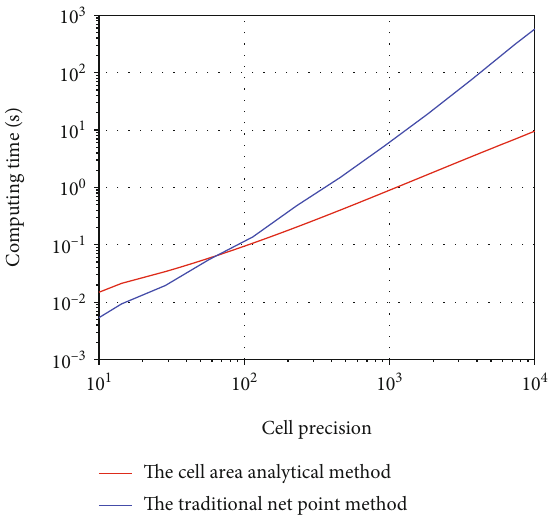
Figure 11: Comparison of the computing time from two algorithms with di ff erent precision for